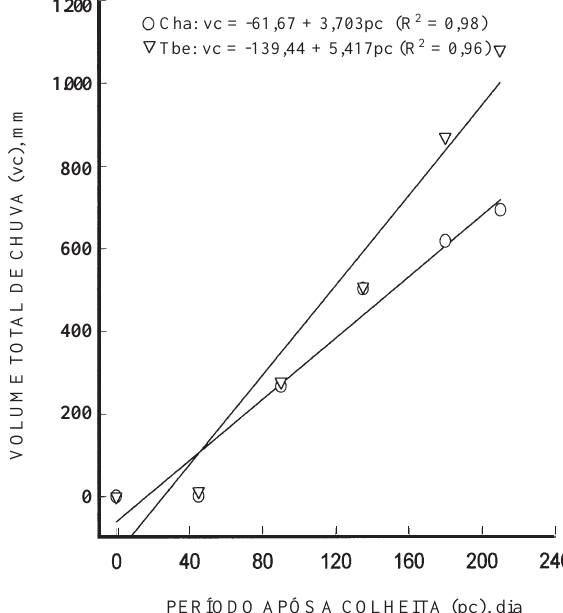
Figura 5. Volume total de chuva (vc), precipitado em Lages (Cha), e Lebon Régis (Tbe), no período de 225 dias após a colheita manual da cultura (pc), de maio a dezembro de 1996.